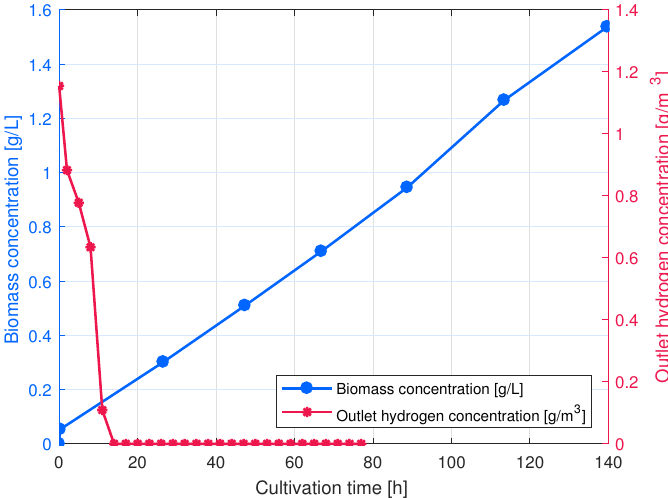
Figure 1. BES cultivation of Cupriavidus necator H16 with immersed electrodes, compared with the hydrogen concentration at the bioreactor gas